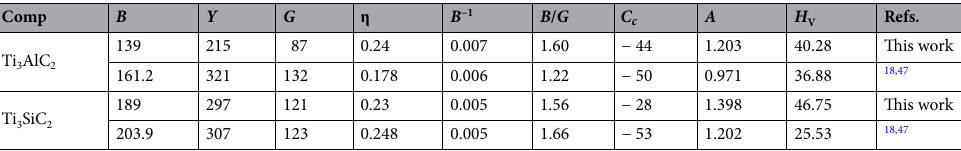
Table 3. Computed bulk modulus B (GPa), Young modulus Y (GPa), shear modulus G (GPa), Poisson’s ratio η, compressibility B −1 (GPa) −1 , Pugh’s ratio ( B/G ), Cauchy pressure C c ( GPa ) , anisotropic factor- A and Vicker’s hardness H v